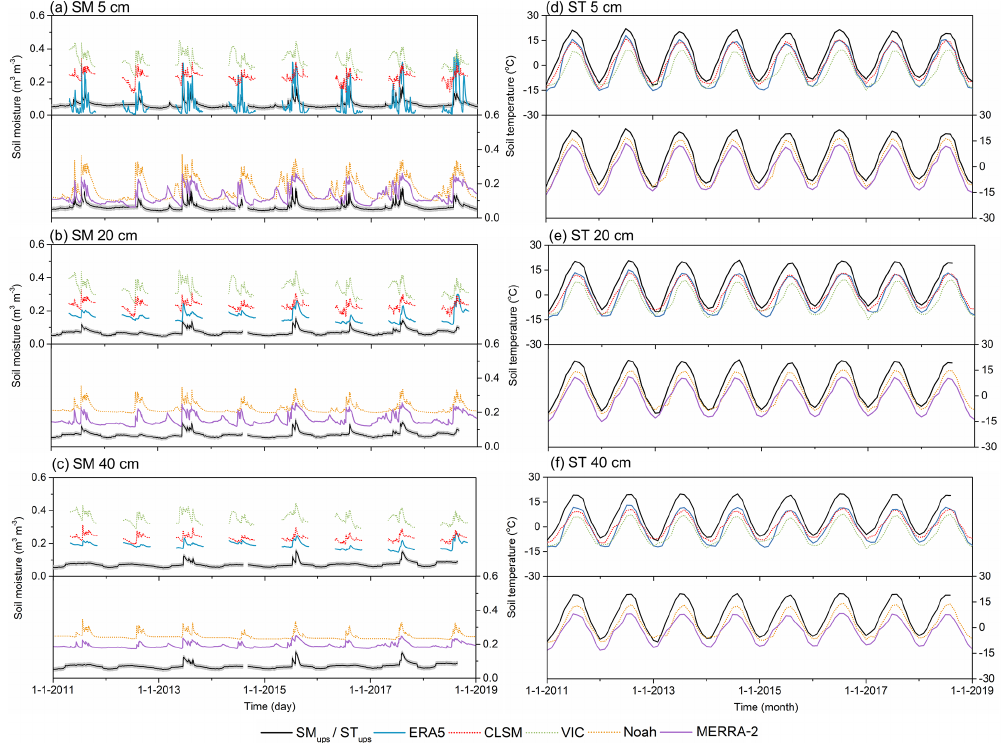
Figure 13. Same as Fig. 11 but for the Shiquanhe network from January 2011 to December